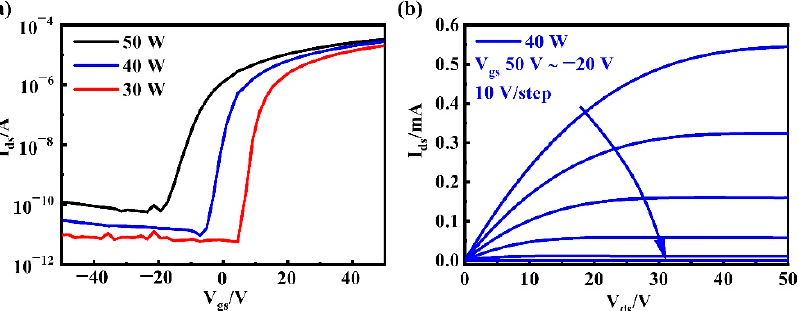
Figure 2. ( a ) Transfer characteristic curves of a-InGaZnO TFTs prepared with different sputtering powers; ( b ) Output characteristic curve of a-InGaZnO TFTs prepared with 40 W sputtering power.